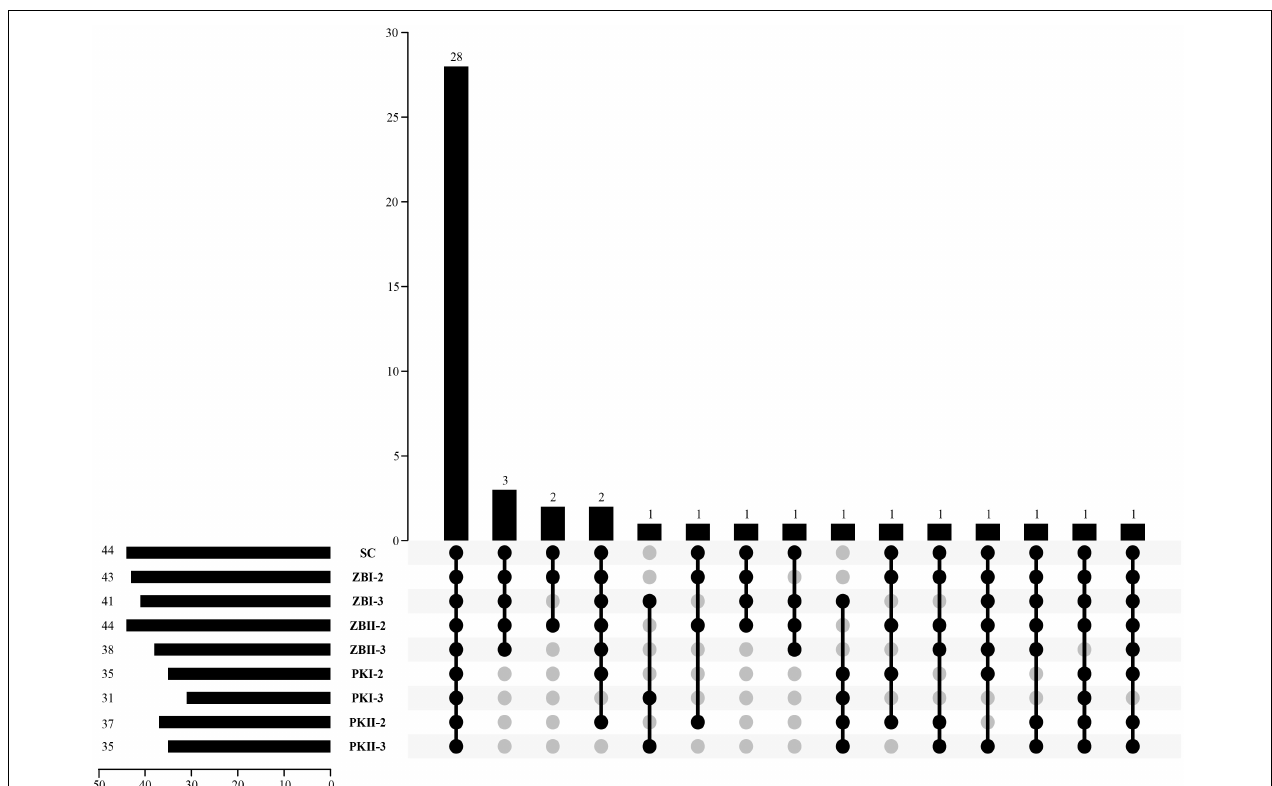
FIGURE 2 | The distributions of wine volatile components in different fermentation trials. The bar chart at the bottom left represents the kinds of volatile components included in each wine sample. The bar chart above represents the kinds of common volatile compounds in the wine samples. The black dot connected by the solid line at the bottom right shows the wine samples contained in the group, and the gray dot shows the wine sample is not included in the